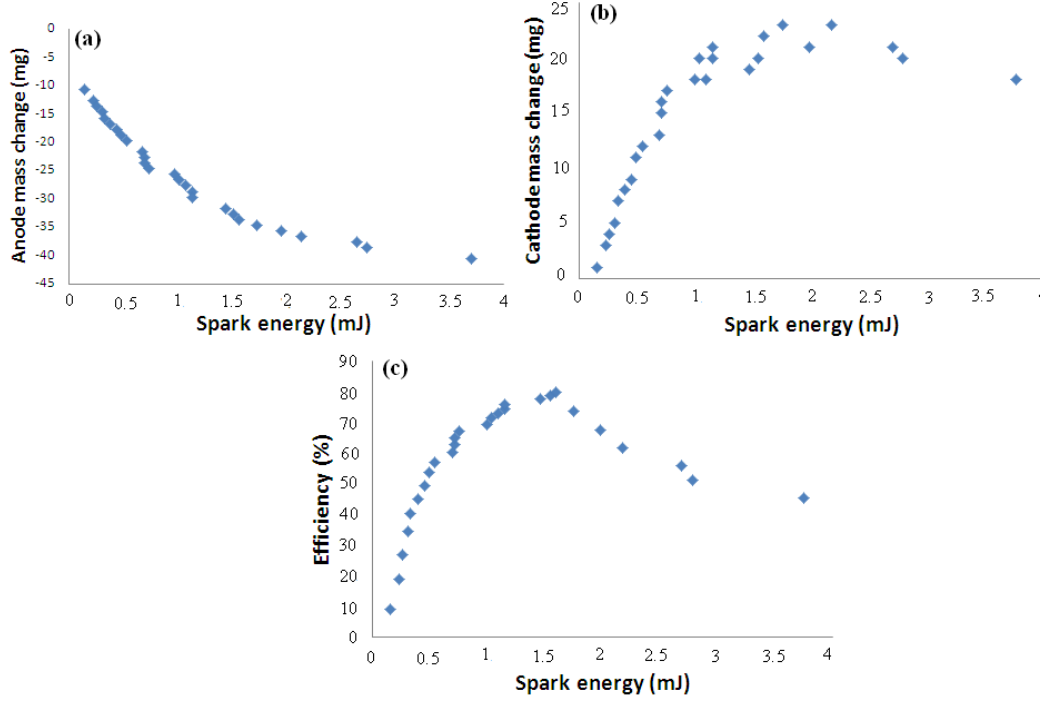
Figure 4. Variation of ( a ) weight of anode ( b ) weight of cathode ( c ) deposition efficiency by spark energy.